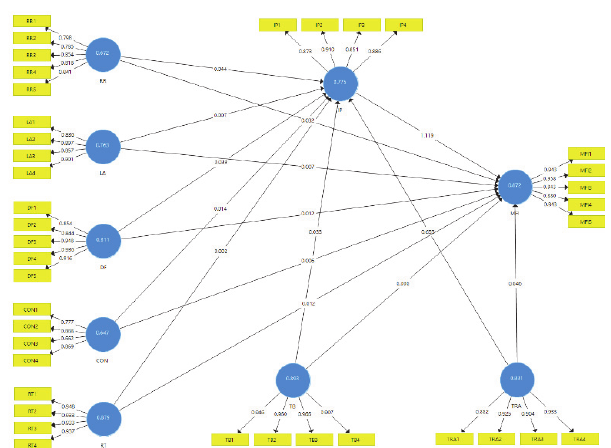
Fig. 2. Measurement Model